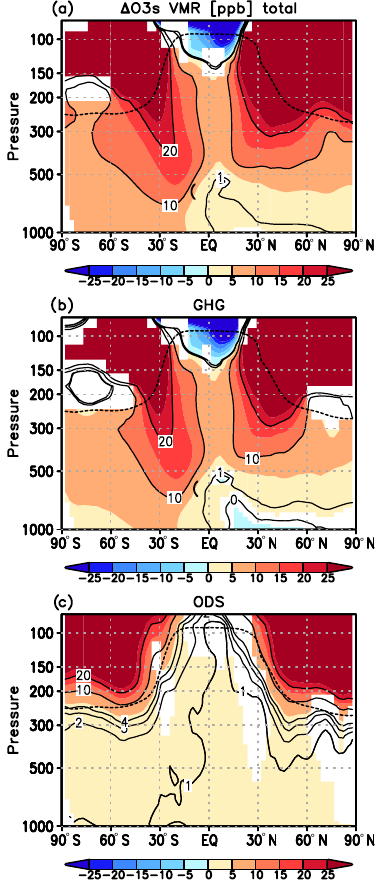
Figure 8. Changes in the volume mixing ratios [ppbv] of the diag- nostic tracer O 3 s for (a) the changes between 2000 and 2100 due to all forcings, (b) the changes between 2000 and 2100 due to in- creasing GHG concentrations and (c) the changes between 2000 and 2100 due to declining ODS levels for June (when the ozone mass flux is maximum in the NH and minimum in the SH; see Fig. 2a). Significant changes at the 95% confidence level are colored. The black dotted line represents the mean tropopause position in the REF2000 simulation. For the small ODS-induced changes (c) ad- ditional contour lines (2, 3, and 4ppbv) are